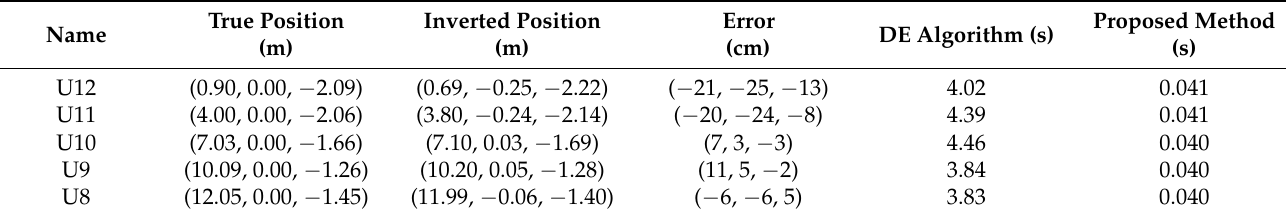
Table 4. Localization results of